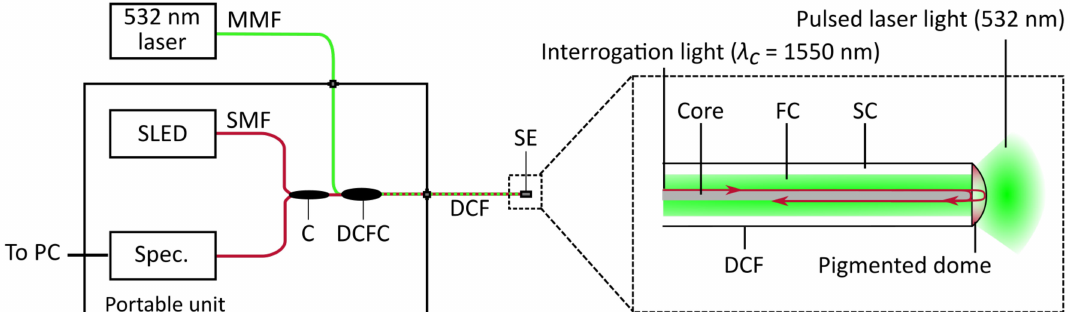
Figure 2. Diagram of the setup for the optical heating experiment. Left: schematic of the combined interrogation and pulsed laser excitation system; MMF: multimode fibre; SLED: superluminescent light-emitting diode; SMF: single mode fibre; Spec.: spectrometer; C: circulator; DCFC: double-clad fibre coupler; DCF: double-clad fibre; SE: sensor element. Right: enlarged schematic of double-clad fibre sensor element; FC: first cladding; SC: second